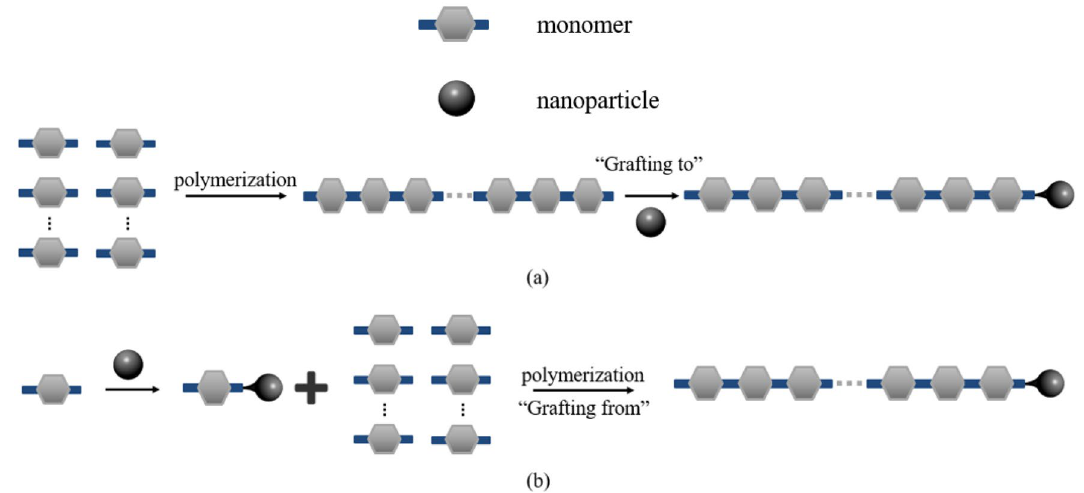
Fig. 6 Schematic description of "grafting to" ( a ) and "grafting from" ( b )